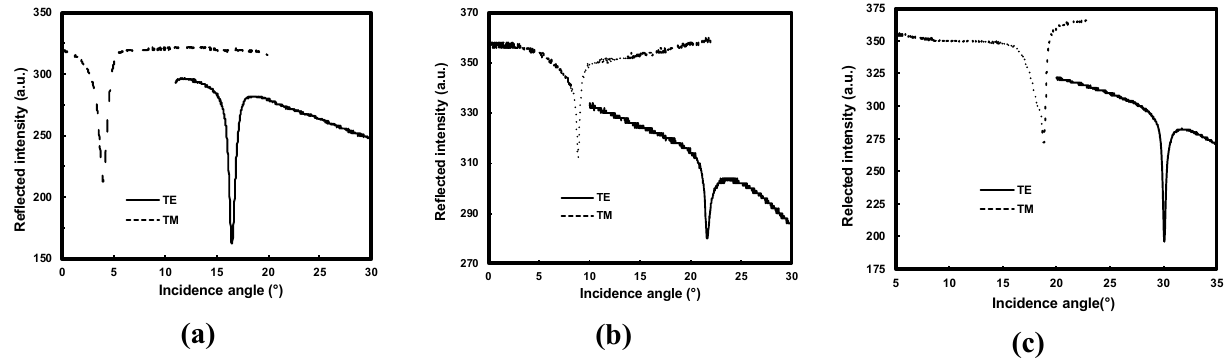
Figure 5. Typical fundamental transverse electric (TE) and transverse magnetic (TM) guided mode spectra of 7-layer ZnO thin film ( a ) undoped, ( b ) 1 at.% Al-doped, ( c ) 2 at.% Al-doped.